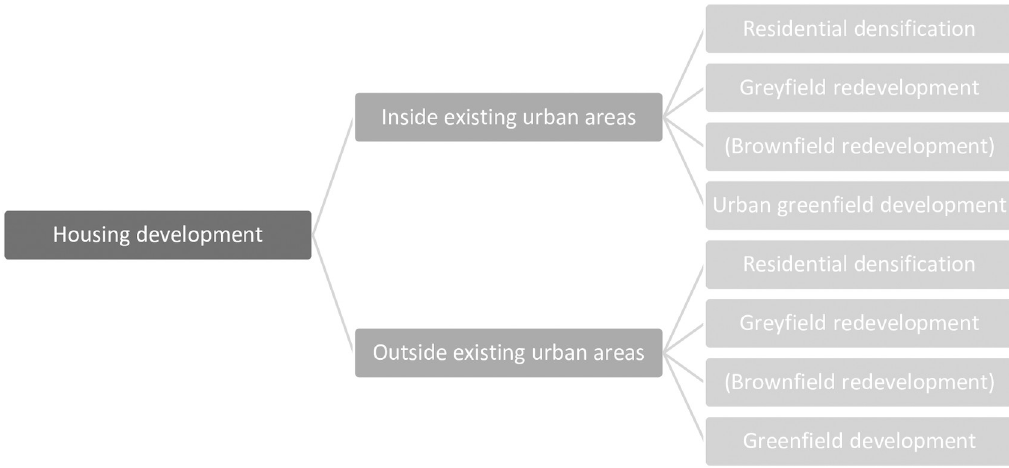
Fig 1. Classification of residential development processes. Brownfield redevelopment is combined with greyfield redevelopment in this particular study due to data limitations.